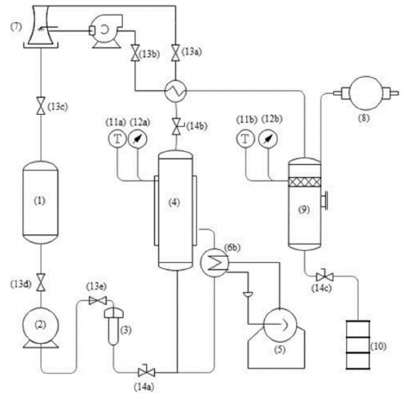
Figure 1. Schematic diagram of CPTE extraction (A) (1. Solvent bank, 2. Pressure pump, 3. Pre- heater, 4. Extraction kettle, 5. Boiler, 6. Heat exchanger, 7. Cooling tower, 8. Vacuum pump, 9. De- sortion tank, 10. Sample collector, 11. Temperature measuring device, 12. Pressure measuring de- vice, 13. One-way valve, 14. Control valve). Briefly, sample was filled into the extraction tank (4). Under the pressure of the pressure pump (3). The solvent is first heated to the desired temperature through a heat exchanger (6) and then flowed into extraction kettle (4) for extraction. The extract went into the desortion tank (9), target extract substance flowed into sample collector (10), the con- densed solvent flowed back into solvent bank (1) to extract